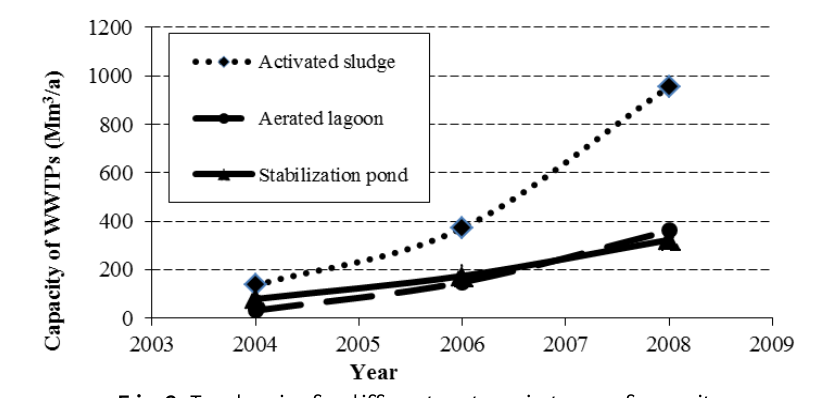
Fig. 2. Tendencies for different systems in terms of capacity. Table 2. Number and frequency of the deficiencies detected by each category.